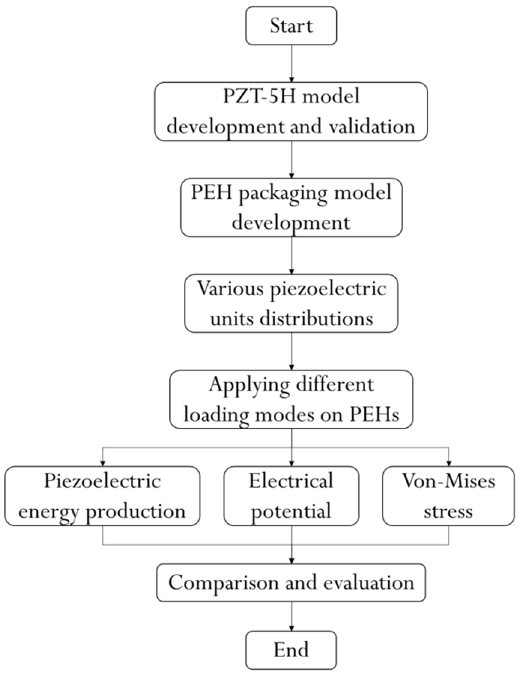
Figure 1. Flowchart of the study.